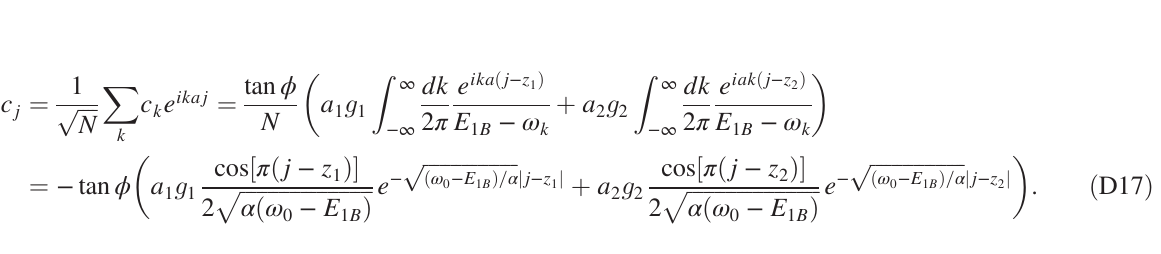
ffiffiffiffiffiffiffiffiffiffiffiffiffiffiffiffiffiffiffiffiffiffiffiffiffi − E α ð ω 0 1 B Þ